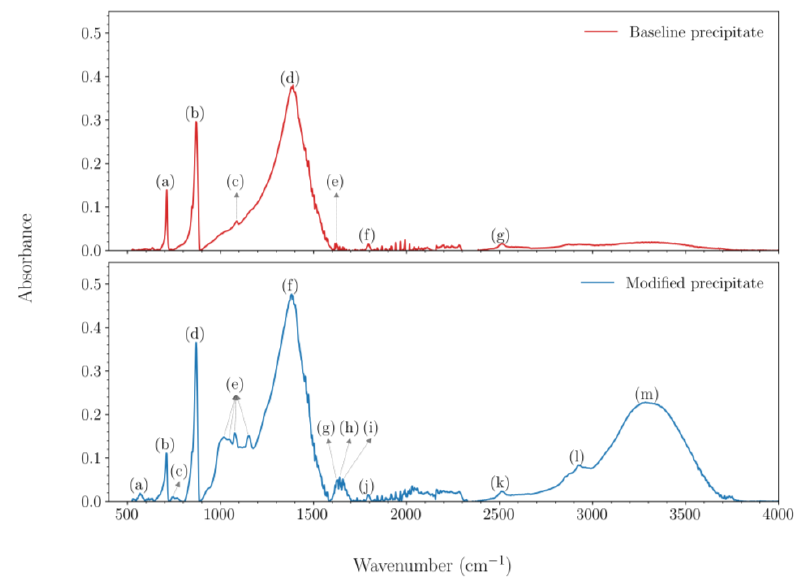
Figure 4. FTIR spectra of the baseline and modified precipitates. Baseline precipitate peaks: (a) 711.6 cm −1 : calcite (ν 4 ); (b) 869.7 cm −1 : calcite (ν 2 ); (c) 1088 cm −1 : calcite (combination band); (d) 1383 cm −1 : calcite (ν 3 ); (e) 1624 cm −1 : calcite (combination band); (f) 1795 cm −1 : calcite (ν 1 + ν 4 ); (g) 2513 cm −1 : calcite (ν 1 + ν 3 ). Modified precipitate peaks: (a) 568.9 cm −1 : calcium phosphates (HPO 42- /PO 43- , ν 4 ); (b) 709.7 cm − 1 : calcite (ν 4 ); (c) 742.5 cm −1 : vaterite (ν 4 ); (d) 869.7 cm −1 : calcite (ν 2 ) (and vaterite (ν 2 )); (e) 1018 cm −1 , 1045 cm −1 , 1078 cm −1 , 1151 cm −1 : calcium phosphates (HPO 42 − /PO 43 − , ν 3 ) and/or lactose (C – O stretch); (f) 1383 cm −1 : calcite (ν 3 ) (and vaterite (ν 3 )); (g) 1624 cm −1 : calcite (combination band); (h) 1641 cm −1 : milk protein (amide I band); (i) 1658 cm −1 : water (H – O – H scissor); (j) 1793 cm −1 : calcite (ν 1 + ν 4 ); (k) 2511 cm −1 : calcite (ν 1 + ν 3 ); (l) 2924 cm −1 : lactose (C – H stretch); (m) 3300 cm −1 : water (O – H asymmetric stretch) and/or lactose (O – H stretch).